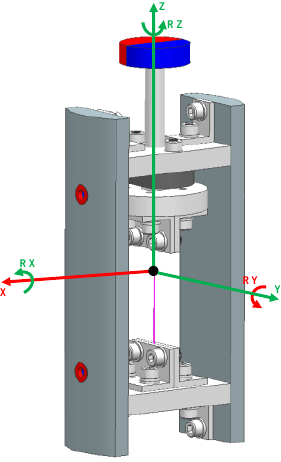
Figure 3. Illustration of the six levitation DoFs. Table 2. Control strategy of the six levitation DoFs.